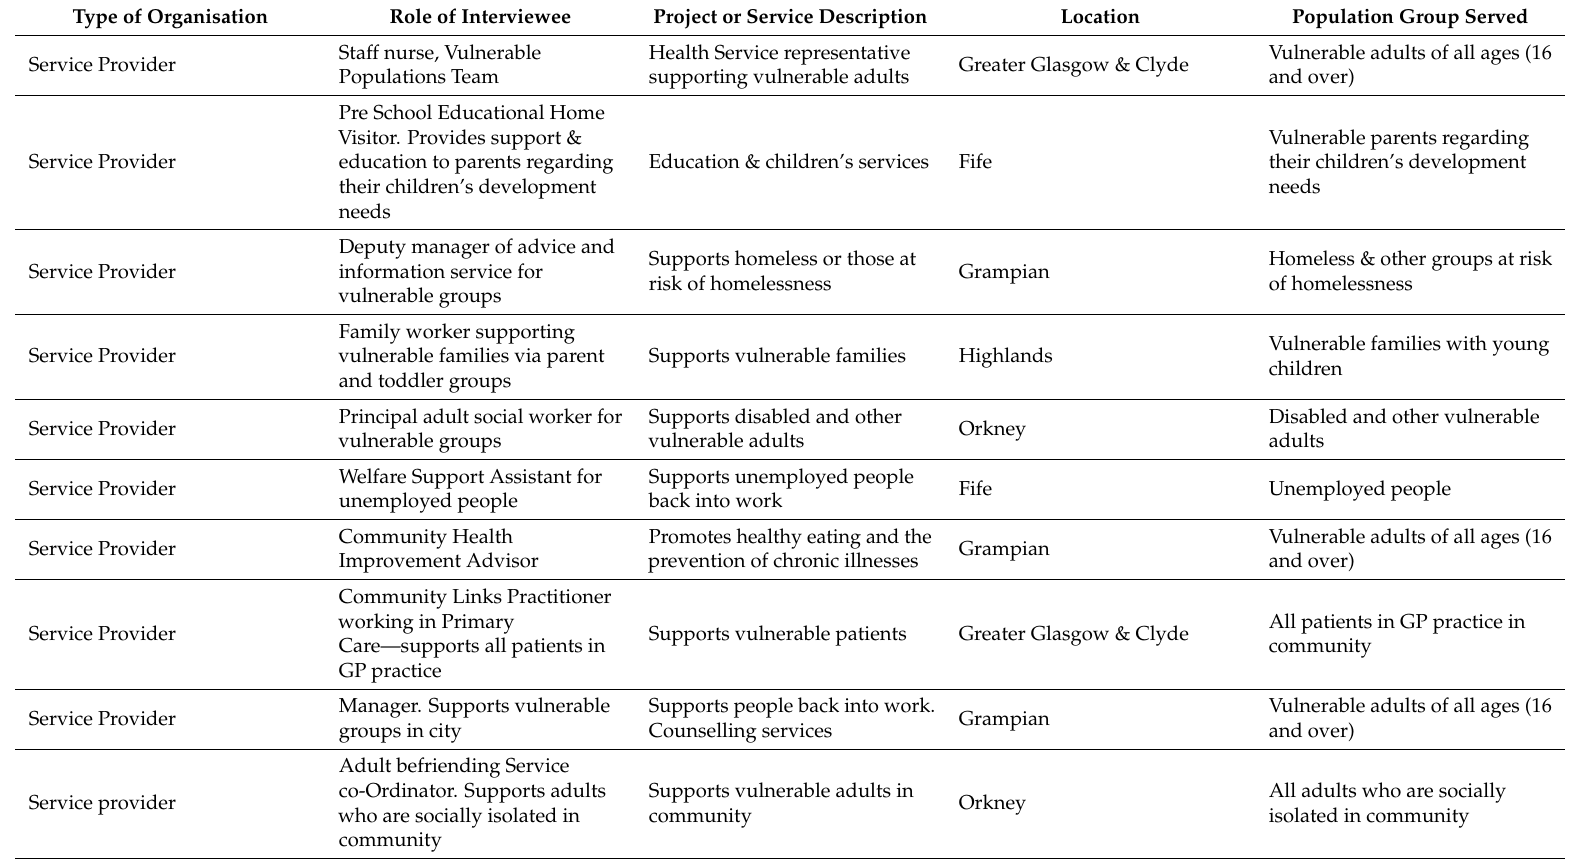
Table A1. Service Provider Informant